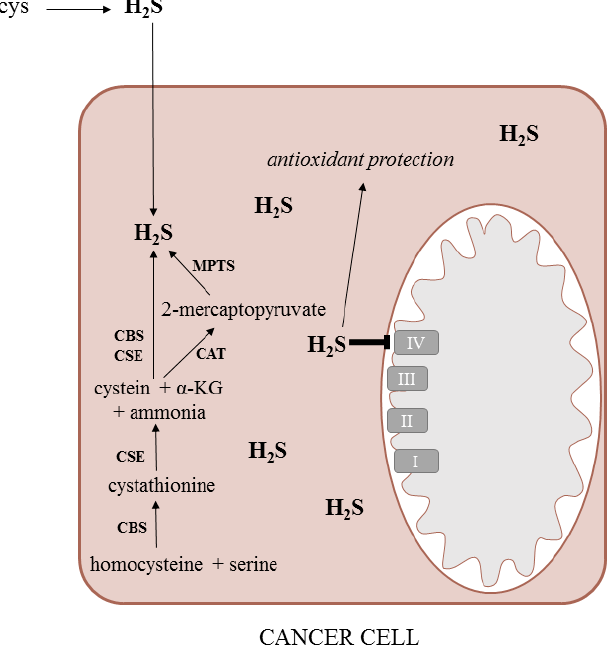
Figure 3. Synthesis and metabolism of H 2 S in the cancer cell ( α -KG—alpha-ketoglutarate, H 2 S— hydrogen sulfide, CAT—cysteine: 2-oxoglutarate aminotransferase, CBS—cystathionine beta-synthase, CSE—cystathionine gamma-lyase, cys—cysteine, MPTS—3-mercaptopyruvate sulfurtrans ‐ ferase).